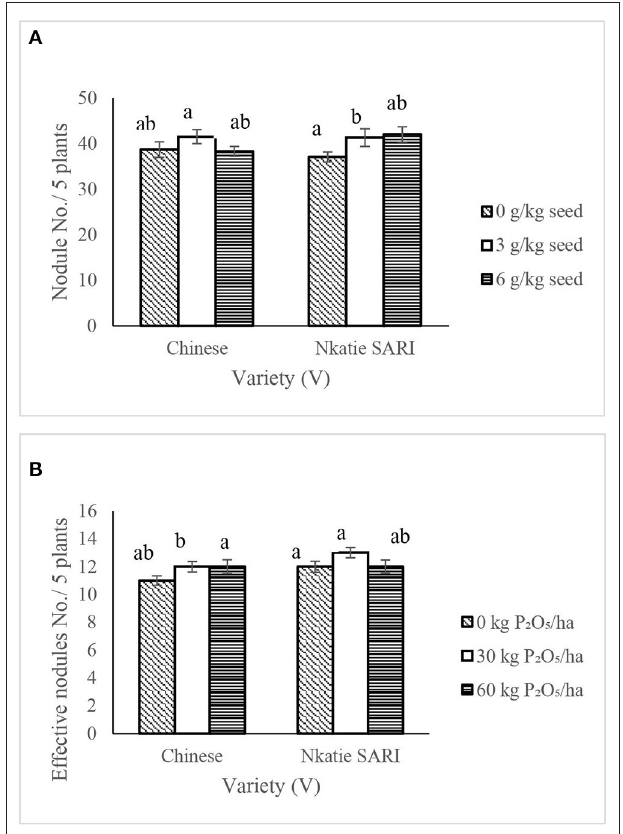
FIGURE 6 | Interactive effect of Innoclant rate (IR) and variety (V) on nodule number per five plants (A) and; P-rate and variety on effective nodule number per five plants of groundnut (B) grown in Haplic Lixisols of northern Ghana. Bars with different letters (in horizontal direction) show significantly different means. Error bars represent standard error of mean.